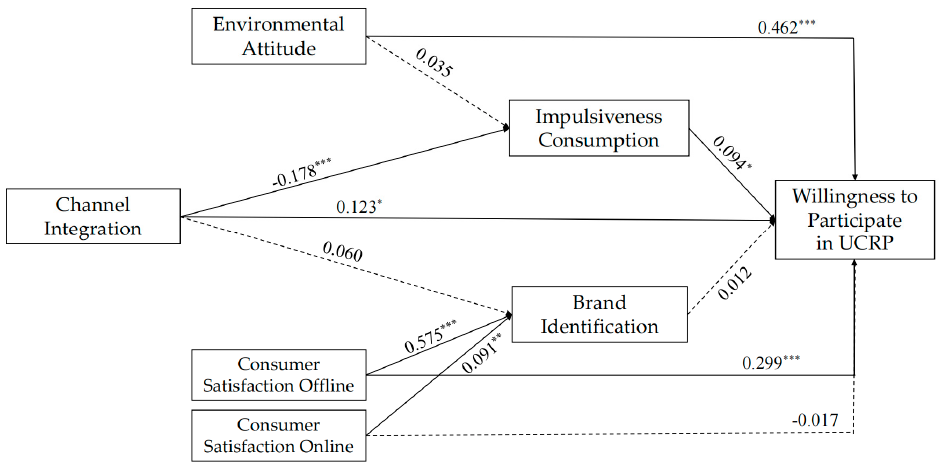
Figure 2. Baseline Measurement Model. Note: *** p < 0.01, ** p < 0.05, * p < 0.1; dotted lines indicate insignificant relations.